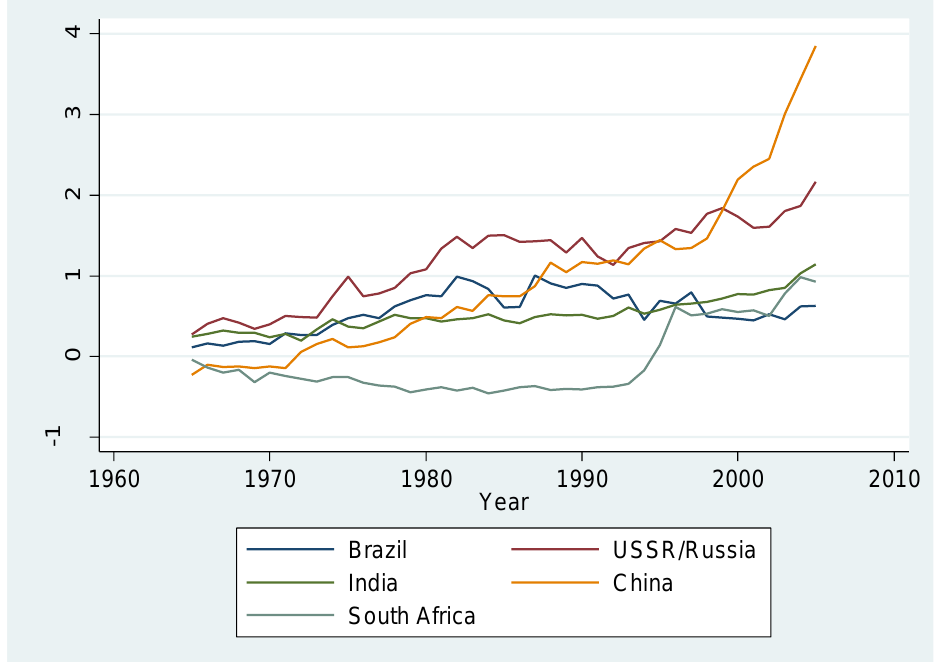
Figure 4: Evolution of Global System Prominence Scores for the BRICS